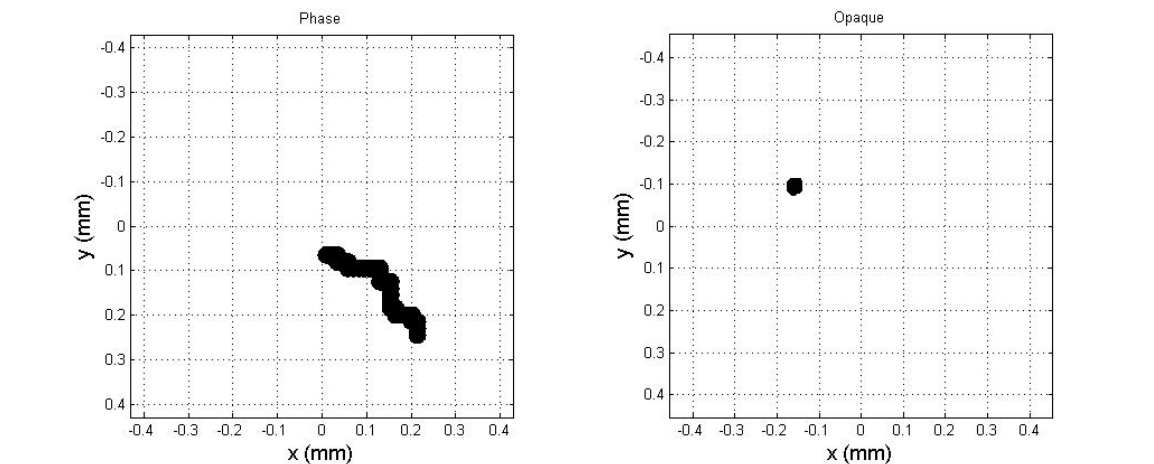
Figure 2. Simulated phase particle ( left ) with phase shift ϕ = 0 . 3 π and opaque particle ( right ).